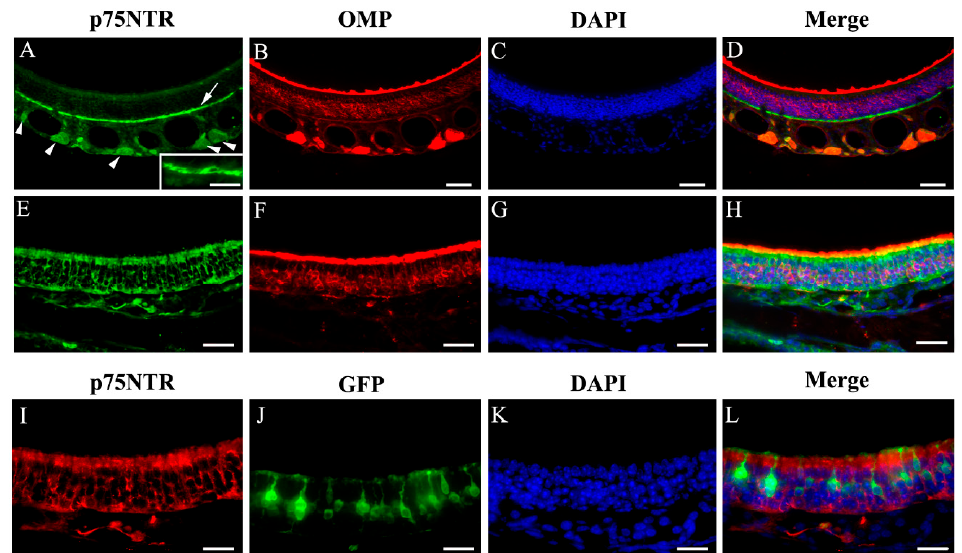
Figure 8. Immunoreactivity of p75NTR in different MOE regions. ( A – D ) Dorsal MOE. ( E – H ) Ventrolateral MOE. p75NTR immunolabel is present in the basal cell layer ( A , indicated by arrow, inset shows an enlarged image of basal cells), in ensheathing cells in and around the olfactory nerve bundles ( A , indicated by arrowheads) and in supporting cells in the ventrolateral region ( E , green; I , red). OMP immunolabel is shown ( B , F , red). GFP signal in TRPM5-expressing OSNs and TRPM5-MCs was intensified using an anti-GFP antibody ( J ). No apparent colocalization of the GFP and p75NTR signal was found. Sections were stained with DAPI to show nuclei (blue, C , G , K ). Scale bar: ( A – D ) 50 µ